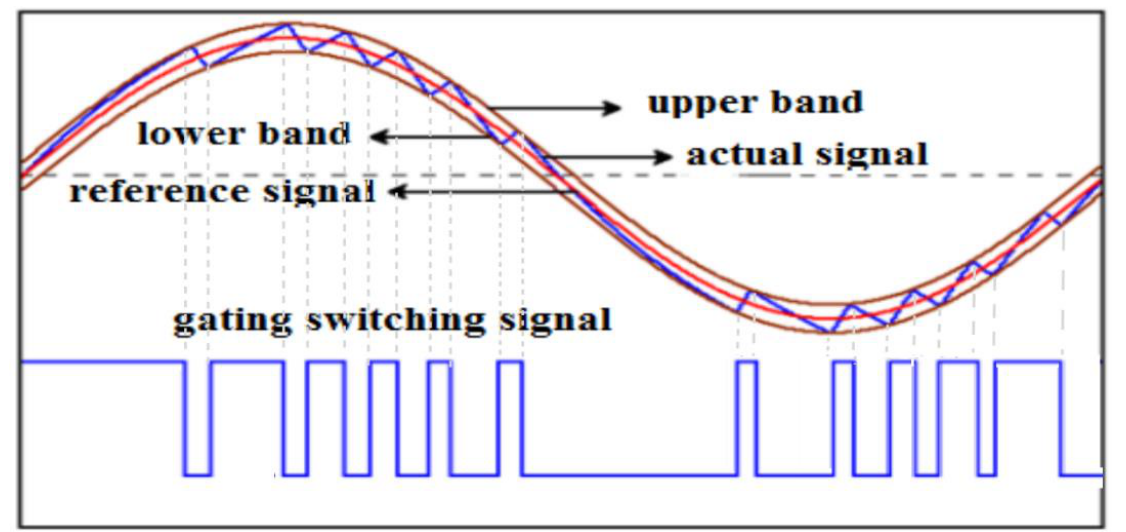
Figure 4. Hysteresis band current waveforms.